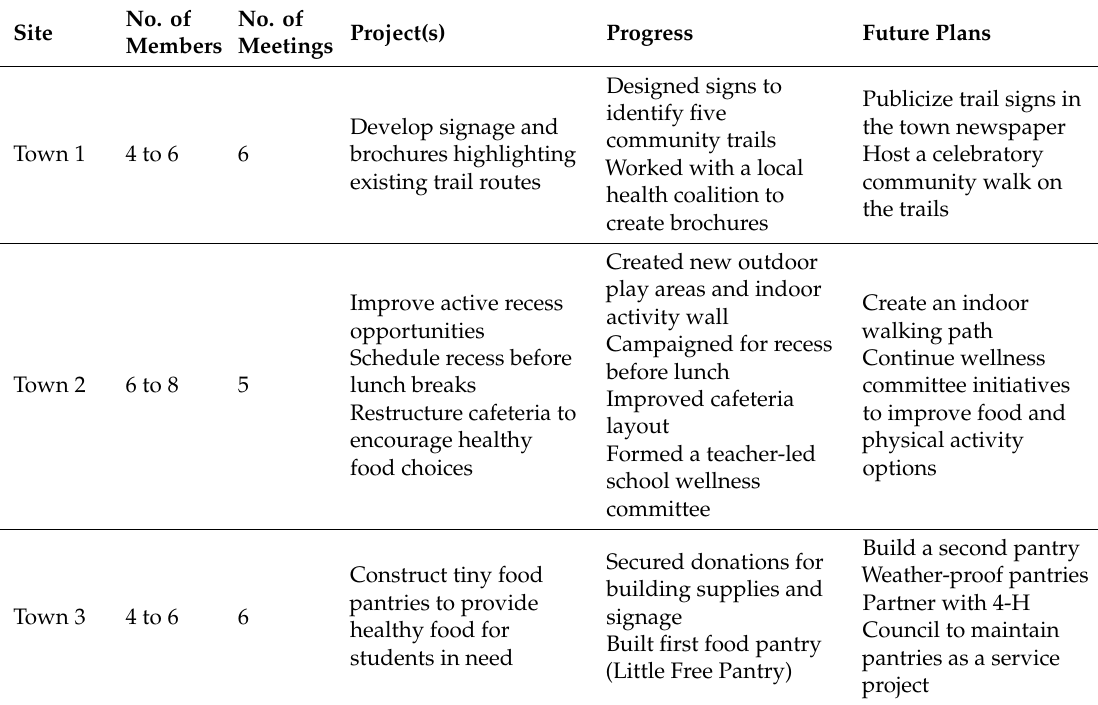
Table 4. Summary of eHEART group